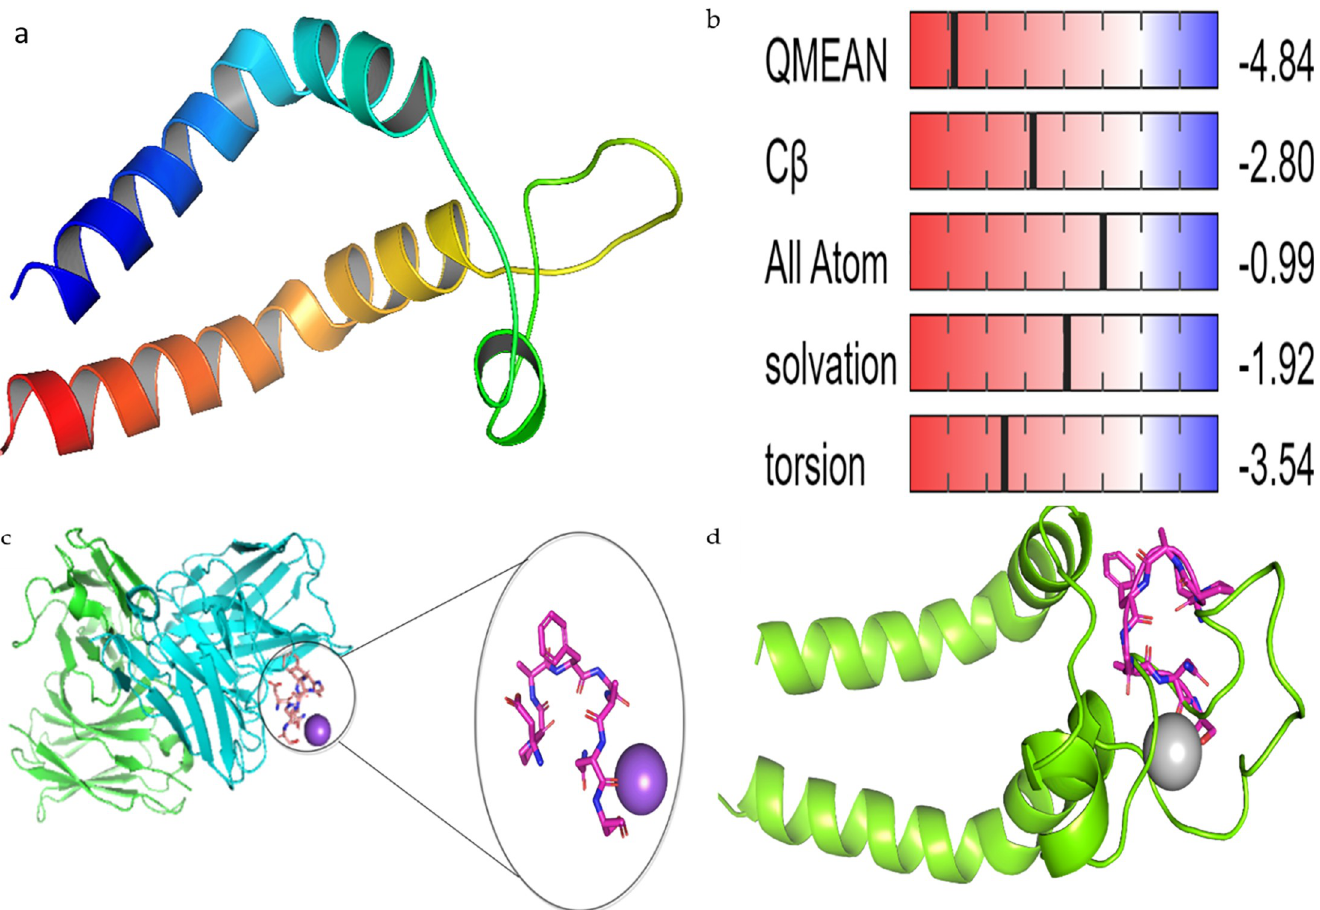
Fig 6. a. Homology Modelled Structure of complete envelope protein of HBV showing a form of Helix-Turn-Helix conformation. b) Quality check checked of the modeled structure with regards to other non-redundant structures deposited in the protein data bank. c) X-ray crystal structure of a human neutralizing antibody bound to an HBV preS1 peptide, which was zoomed out to show the structure of the peptide. d) Aligned structure of the modelled HBV envelope and crystal structure of Pres1 peptide.